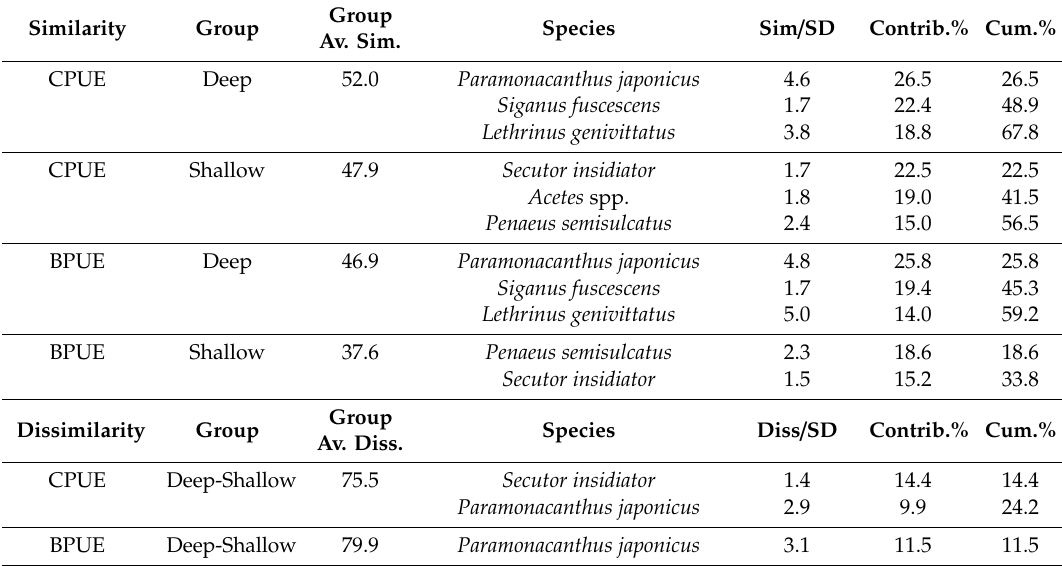
Table 1. Details of percentage similarity (SIMPER) analyses for Group depth (Deep vs. Shallow) identified as being significantly di ff erent. Fish species by catch per unit e ff ort (CPUE) and biomass per unit e ff ort (BPUE), which contribute to the similarity within and dissimilarity among each group, are given. Similarity (SIM / SD) or dissimilarity (DISS / SD) ≥ 2 indicates consistency of a species contribution amongst samples (trawls); Contrib. % is the percent contribution of a species to the Groups average similarity (Av. Sim.) / dissimilarity (Av. Diss.); Cum.% is the cumulative percent contribution of multiple species to Group Av. Sim.